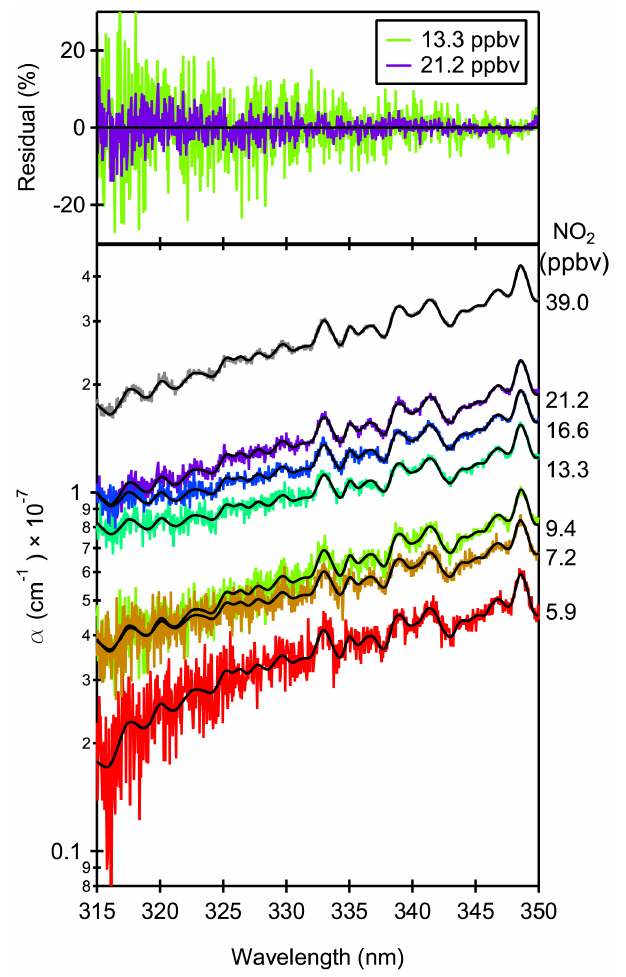
Figure 3. Measured α(λ) for 1min standard additions and calcu- lated spectral fits for seven NO 2 concentrations from 6 to 39ppbv. Two fitting residuals are shown in the upper panel. The average fit uncertainty for all concentrations shown is 360pptv NO 2 .